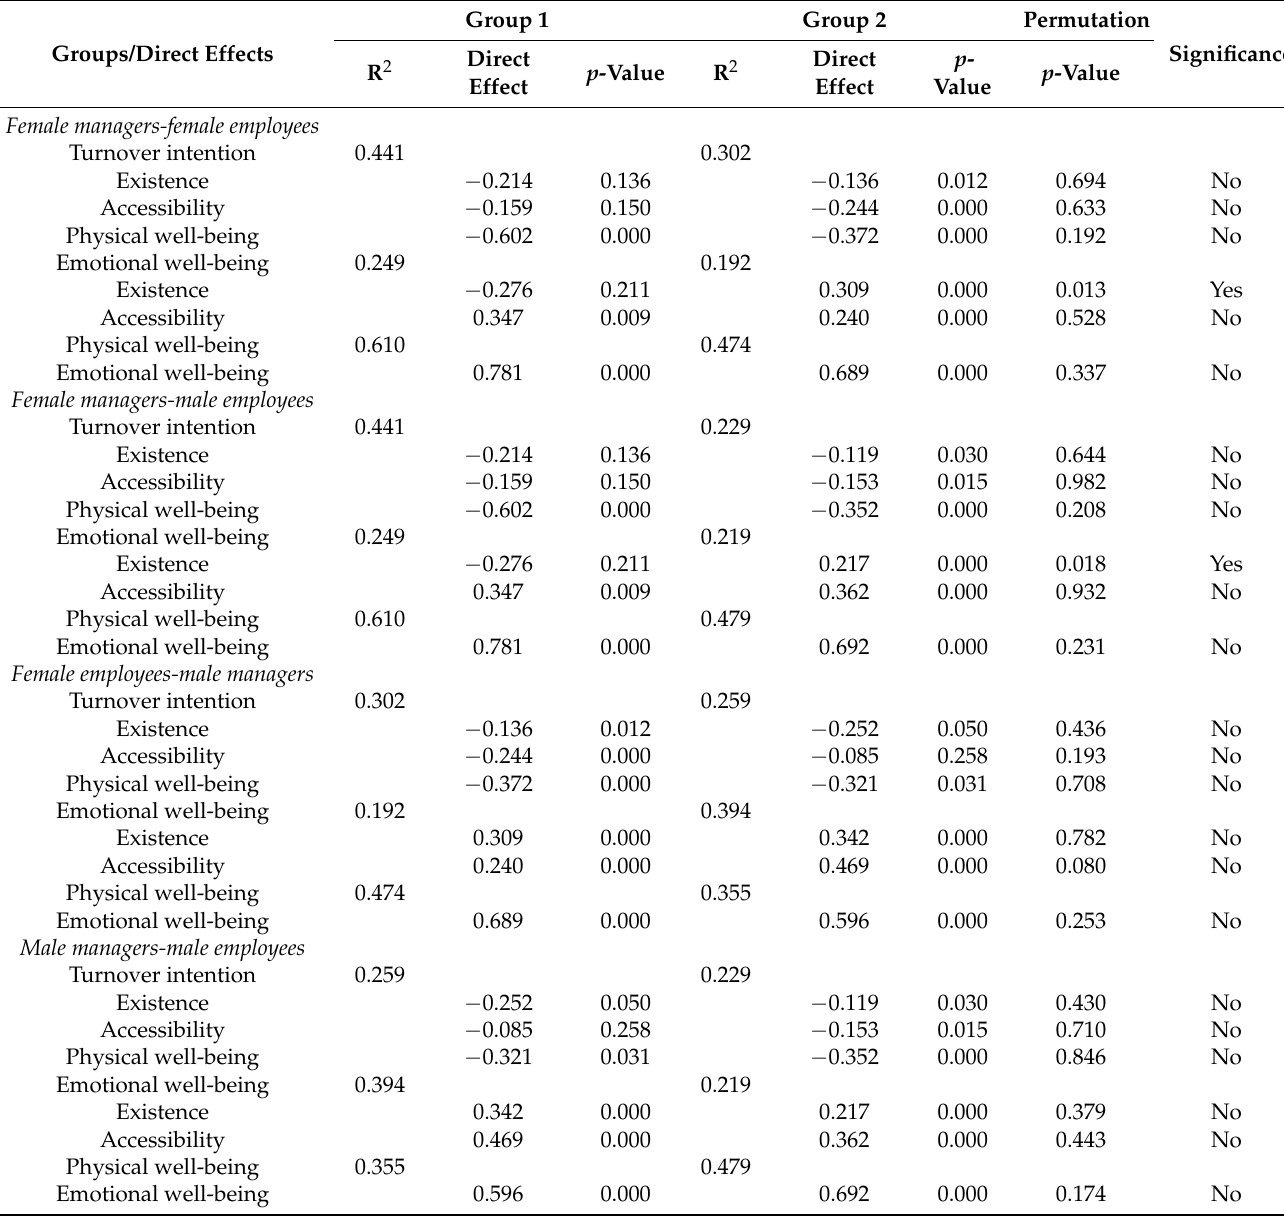
Table 6. Multi-group analysis based on the permutation